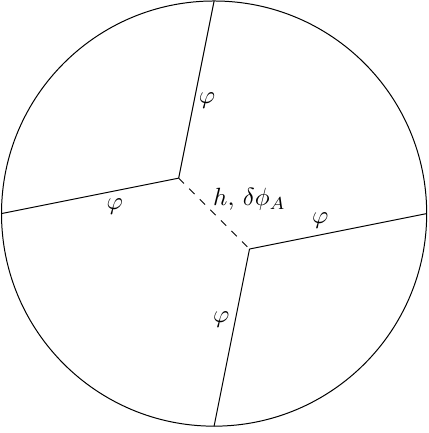
Figure 3 . Exchange diagrams for four point